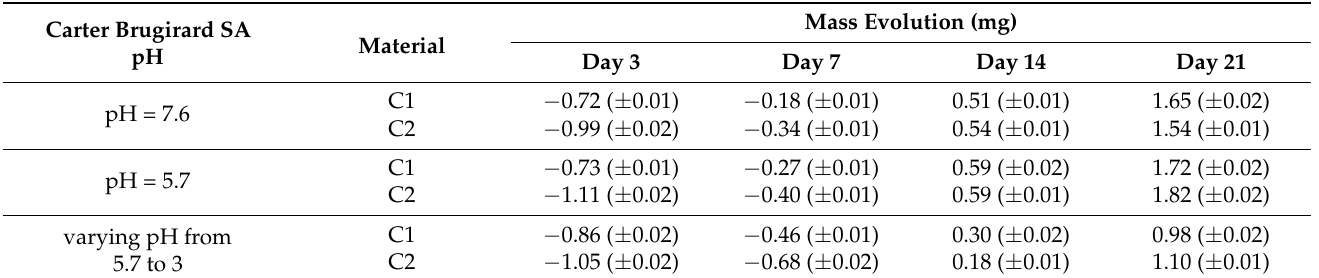
Table 4. Mass evolution of the C1 and C2 samples after immersion in artificial saliva. Carter Brugirard